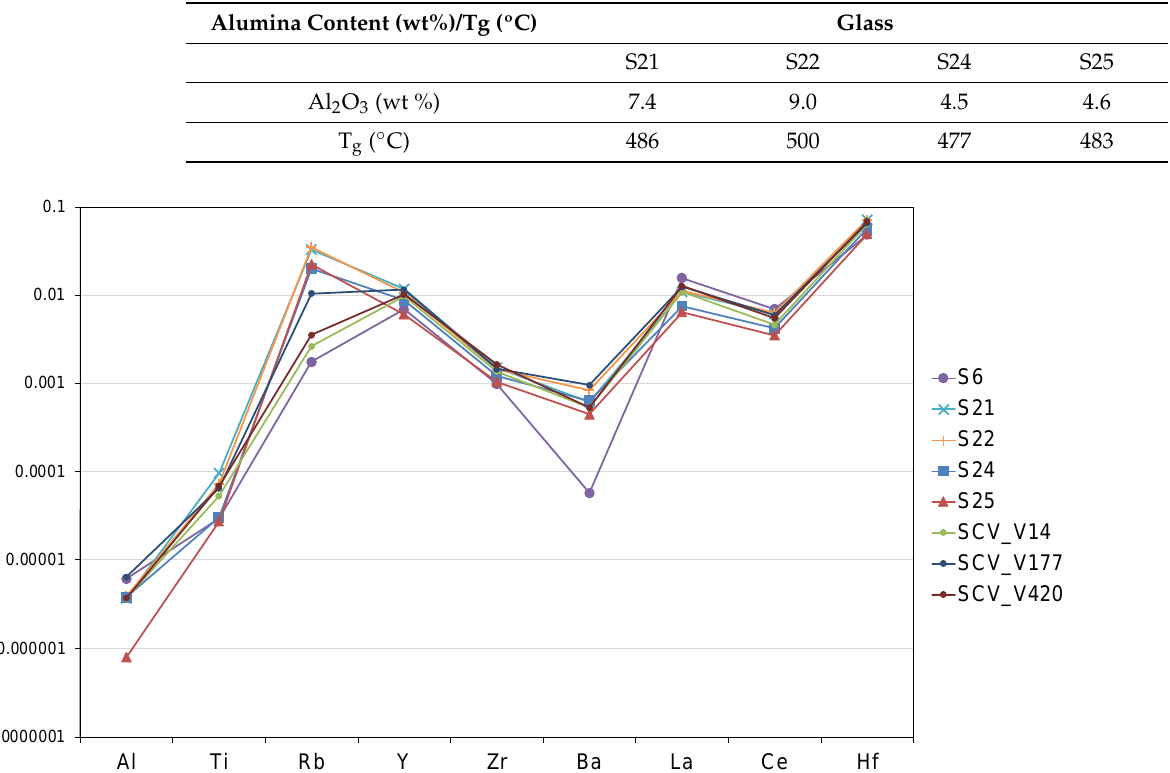
Figure 9. Contents of some trace elements and rare earth elements normalised to the upper Earth crust [31] for the synthesised glass collected in Coimbra and identified as probable sources for glass production, and three SCV historical glasses probably made with Si sources collected in Coimbra in logarithmic scale.